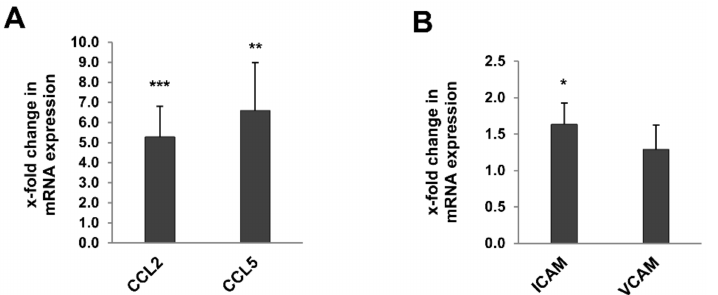
Figure 7. Expression of chemokines and adhesion marker genes in kidneys of 3- and 24-month-old rats by RT-qPCR. The expression of the chemokines CCL2 (MCP-1) and CCL5 (RANTES)( A ) and the adhesion molecule ICAM1 ( B ) in the whole kidney of 24-month-old rats was significant increased, while expression of VCAM1 was comparable in 3- and 24-month-old rats ( A , B ). Data was normalized with respect to the corresponding values determined in 3-month-old rats. p -values ≤ 0.05, ≤ 0.01, and ≤ 0.001 are indicated by one, two or three asterisks,